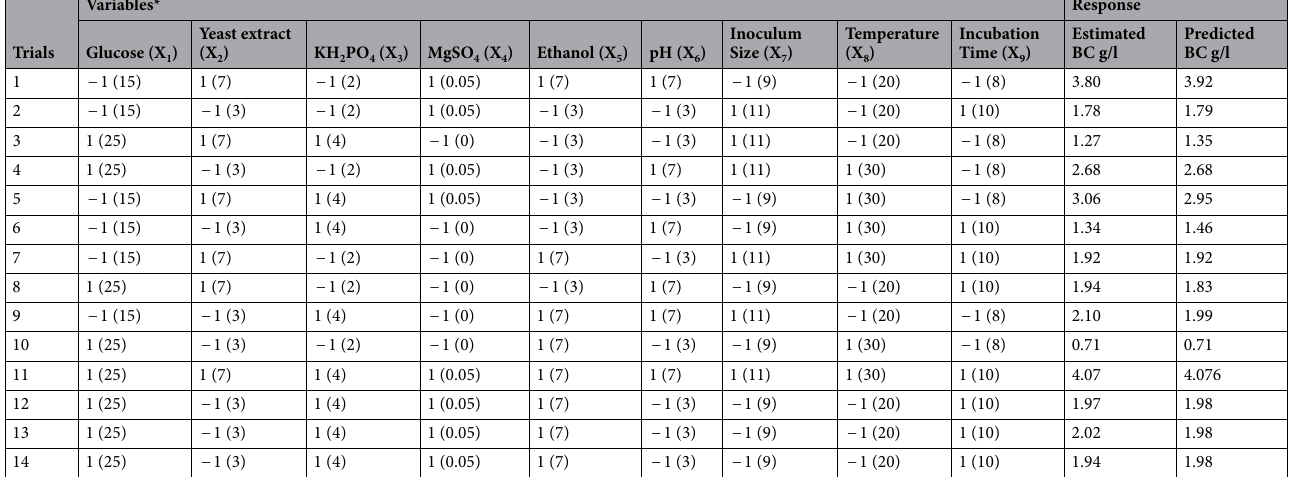
Table 2. PBD for studied nine variables with coded, real values and response (estimated and predicted) for their contribution to enhanced BC production. Variables*: X 1 –X 9 (variable); the coded low and high level are presented as − 1 and 1, respectively. Variable levels are presented between brackets expressed as g/l for X 1 –X 4 ; ml for X 5 - X 7 -; °C for X 8, and days for X 9